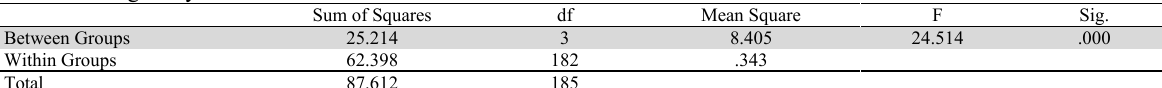
The results of Multiple Comparisons